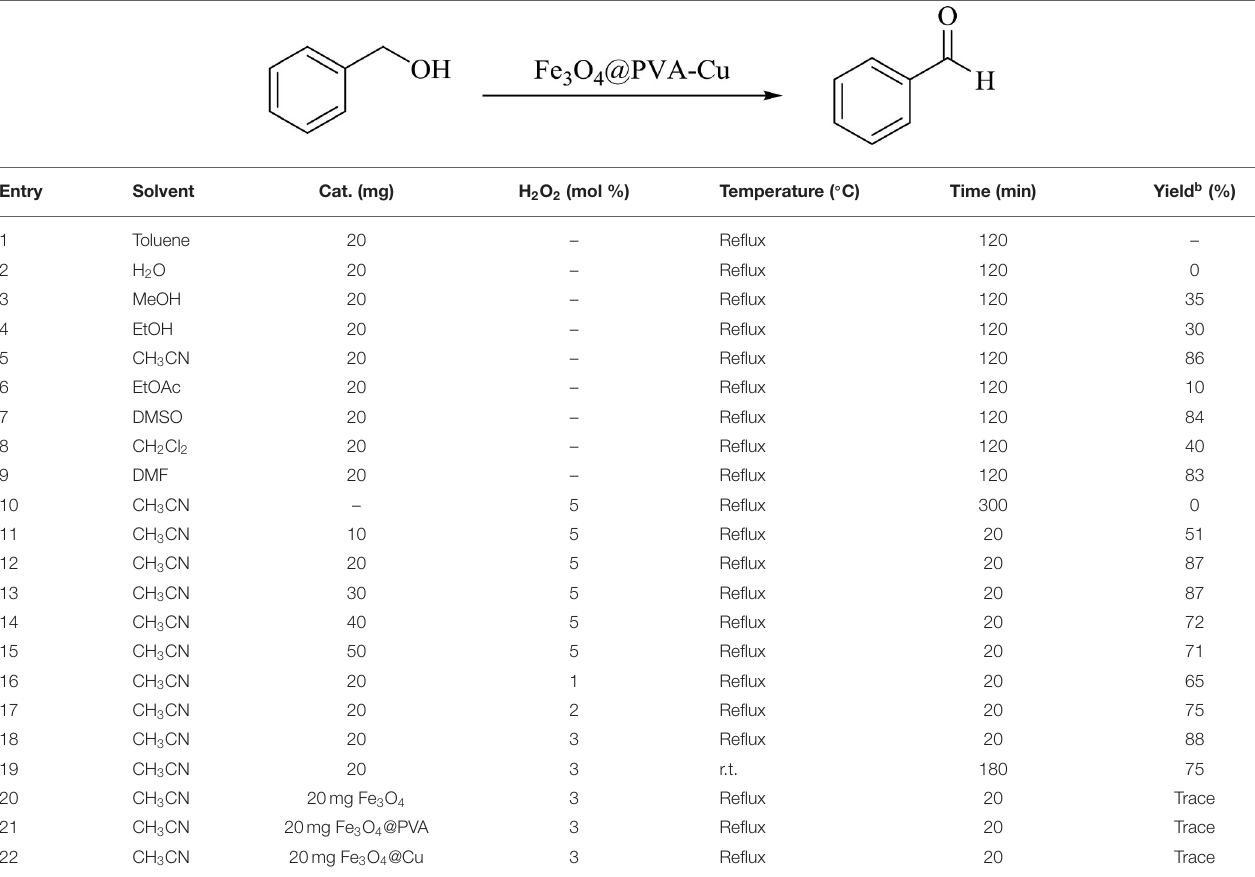
TABLE 3 | Optimization of reaction conditions for the selective oxidation reaction of alcohols into aldehydes and ketones using Fe 3 O 4 @PVA-Cu nanoparticles a